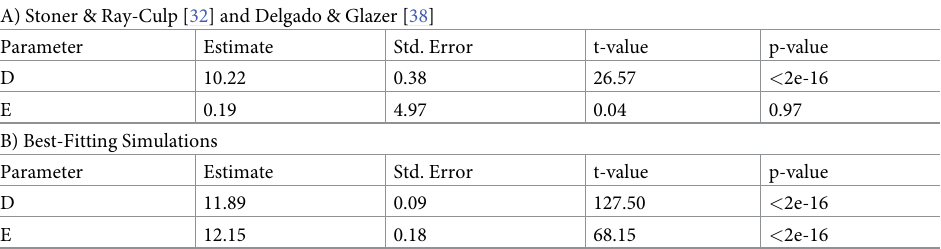
Table 4. Asymptotic regression model fit statistics for mating vs.